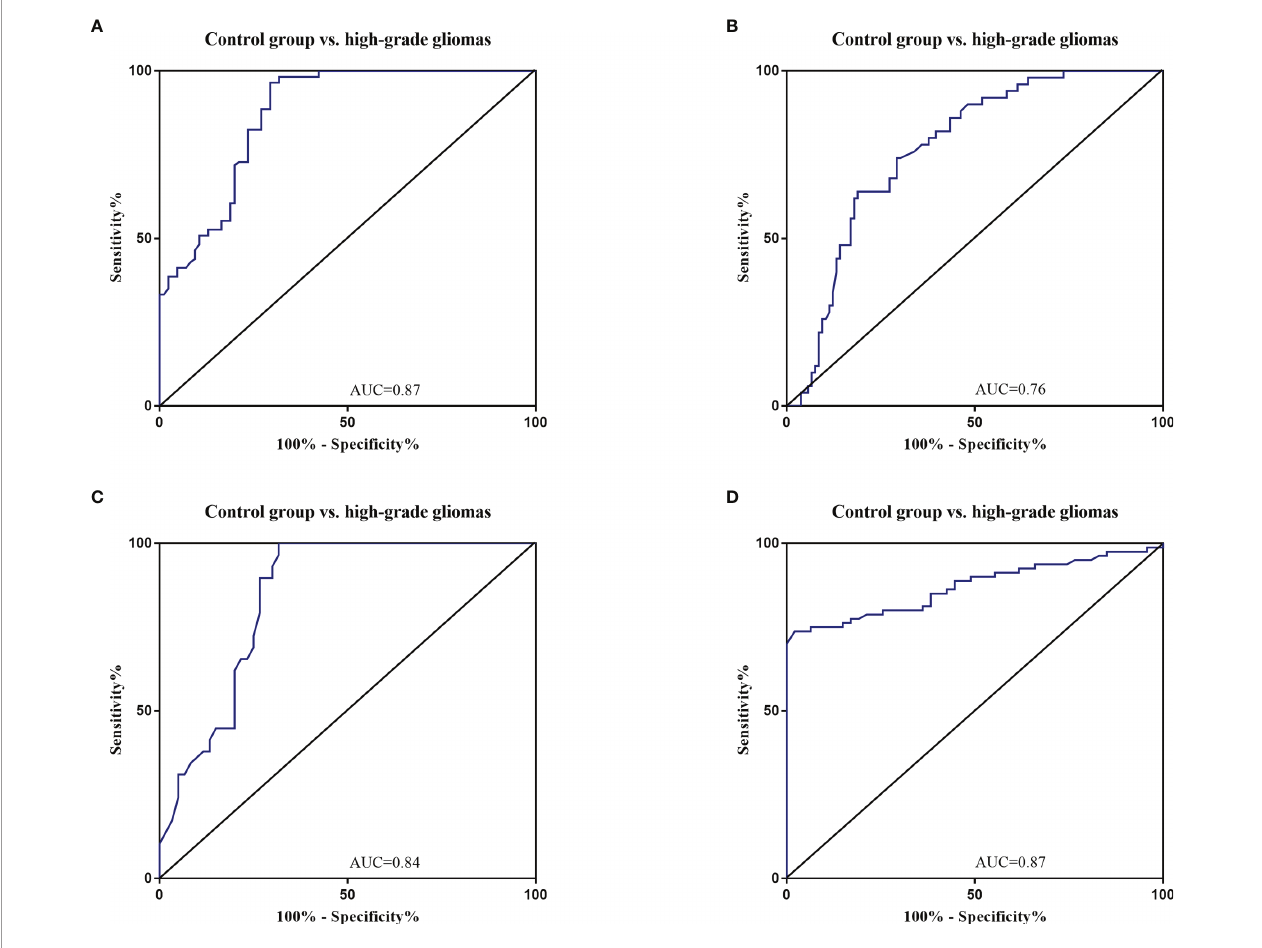
FIGURE 8 | Receiver Operating Characteristic (ROC) curves for circulating miR-181a/b, miR-410 and miR-155 for high-grade glioma patients after surgery (A – D) . The area under the curves (AUCs) for circulating miR-155 (A) , miR-410 (B) , miR-181a (C) , and miR-181b (D) were 0.87, 0.76, 0.84, and 0.87, respectively, suggesting that these circulating miRNAs can distinguish high-grade glioma patients after surgery from control group.